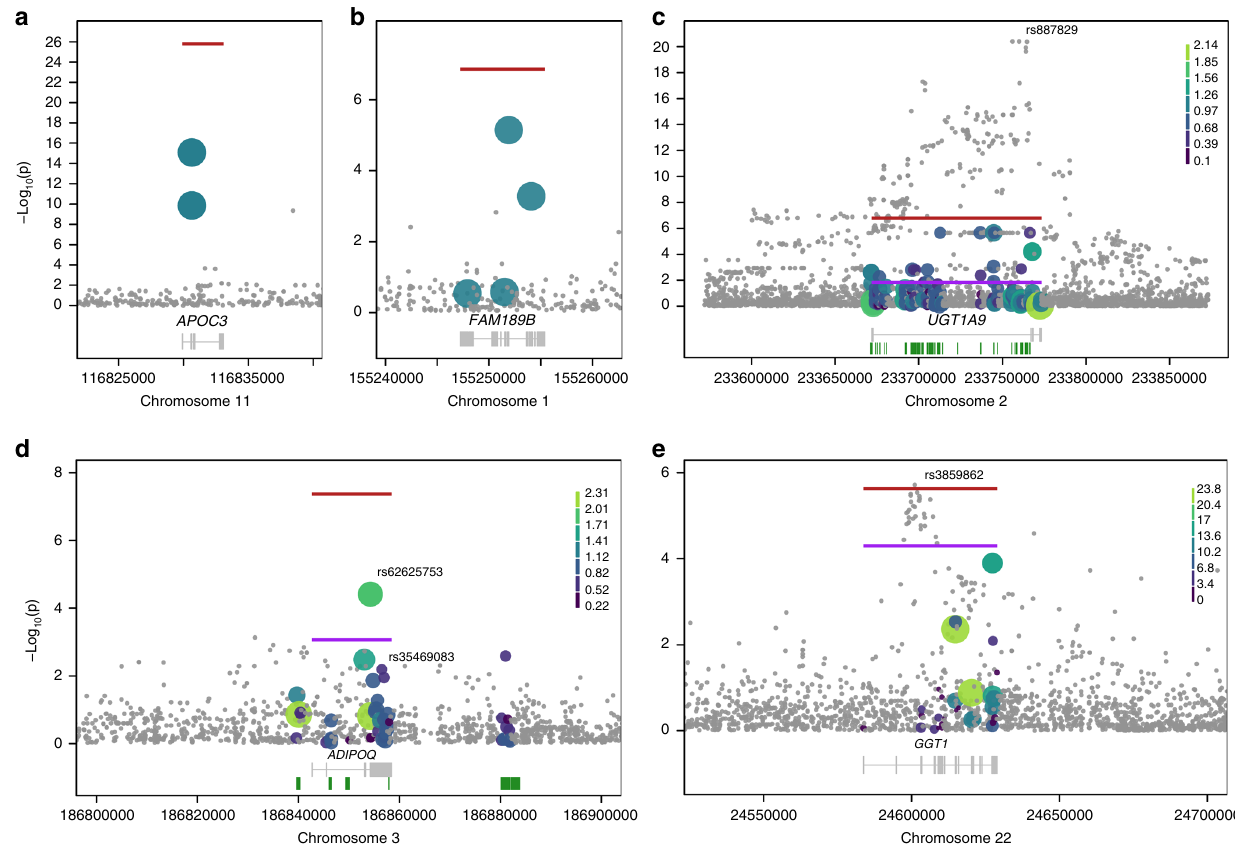
Fig. 3 Regional association plots for burdens in APOC3, FAM189B, UGT1A9, ADIPOQ, and GGT1 . Red lines denote the burden P -value and extend over the tested gene. Purple lines indicate the conditioned P -value for the variant described in the text (variants rs887829, rs62625753, and rs3859862 in c , d , e . respectively). Small grey dots indicate single-point P -value for variants in the region not included in the test. Larger coloured dots represent variants included in the test, with size and colour proportional to the score used in the most signi fi cant test (Supplementary Table 1 and Supplementary Data File 1). When no weights are applied ( a and b ), included variants are coloured blue-green. In the gene track below the regional plots, green bars below the gene, if present, denote regulatory regions associated with the gene which were used to include variants in the burden. These are present only for genes where regulatory regions were included in the